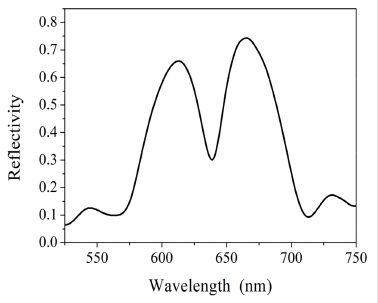
Figure 10. Reflection spectra of a measured porous silicon microcavity.